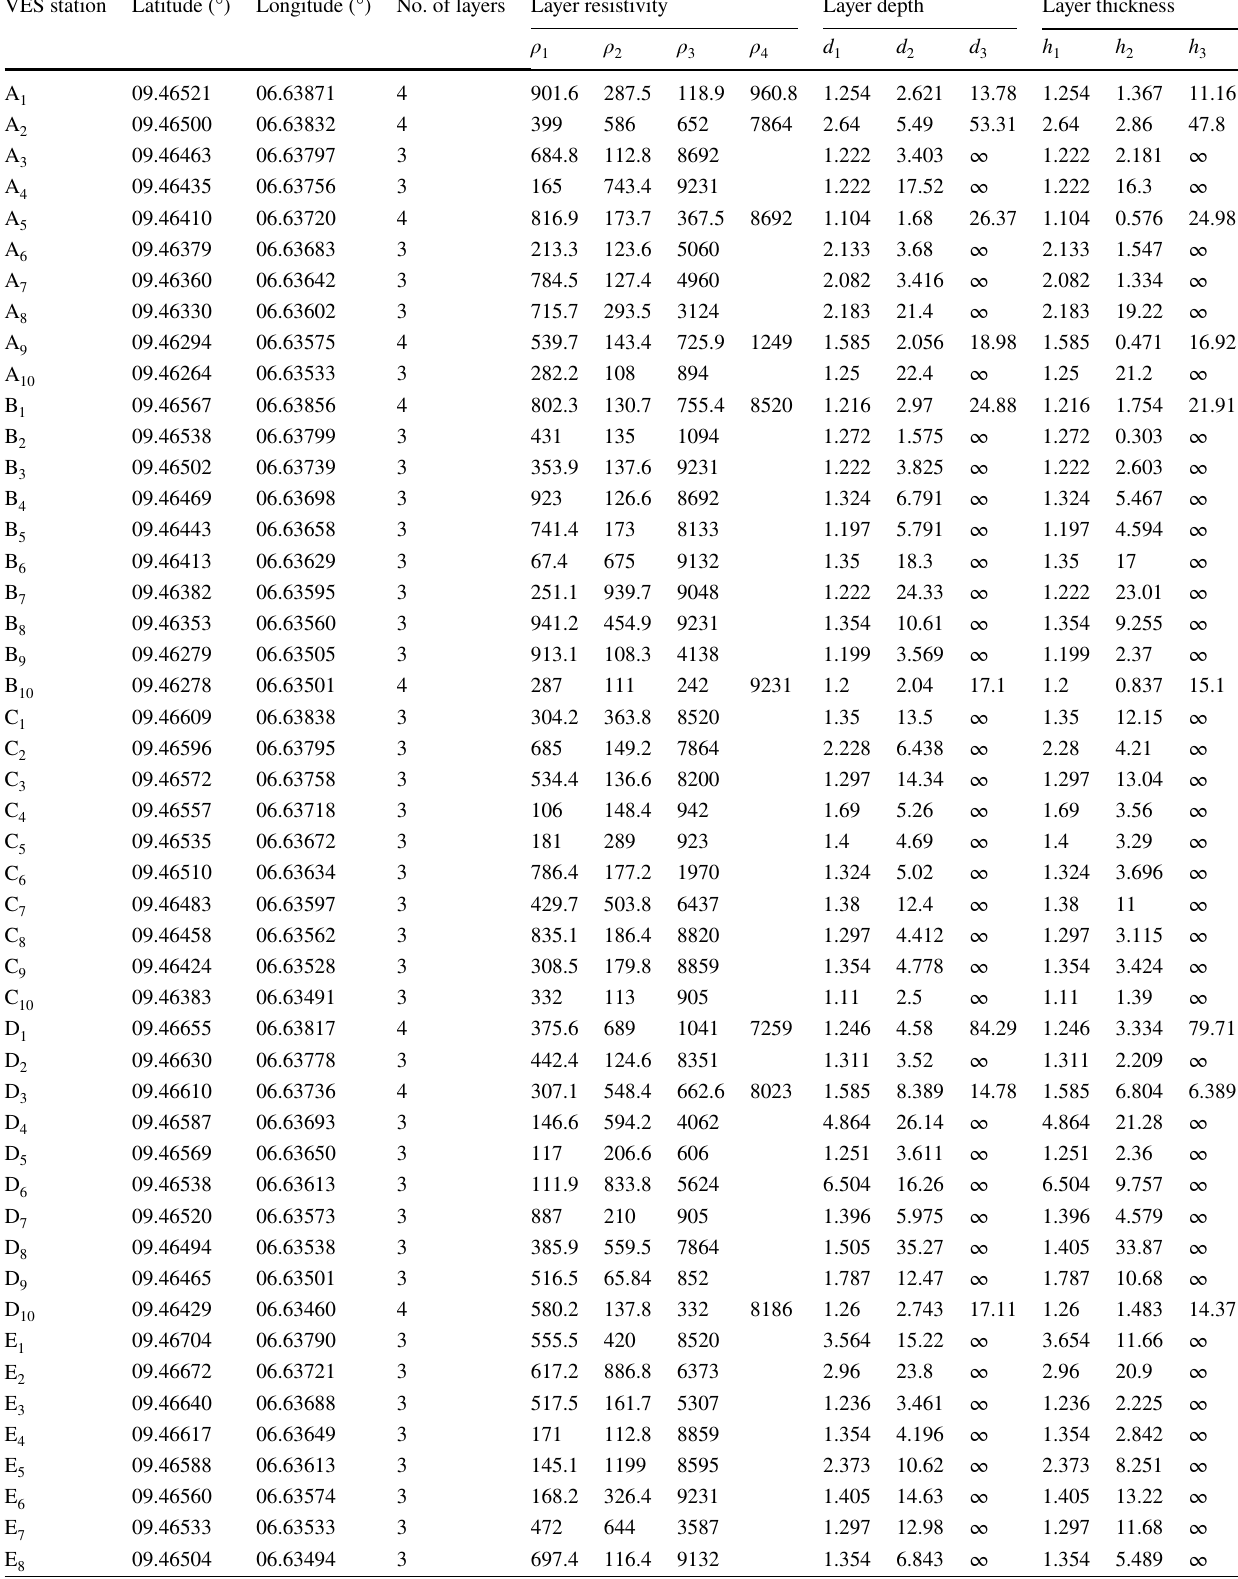
Table 3 Layer resistivity, depth and